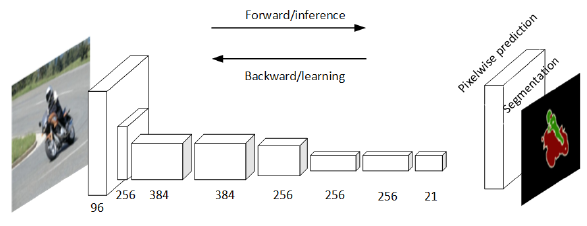
Figure 12. Architecture of